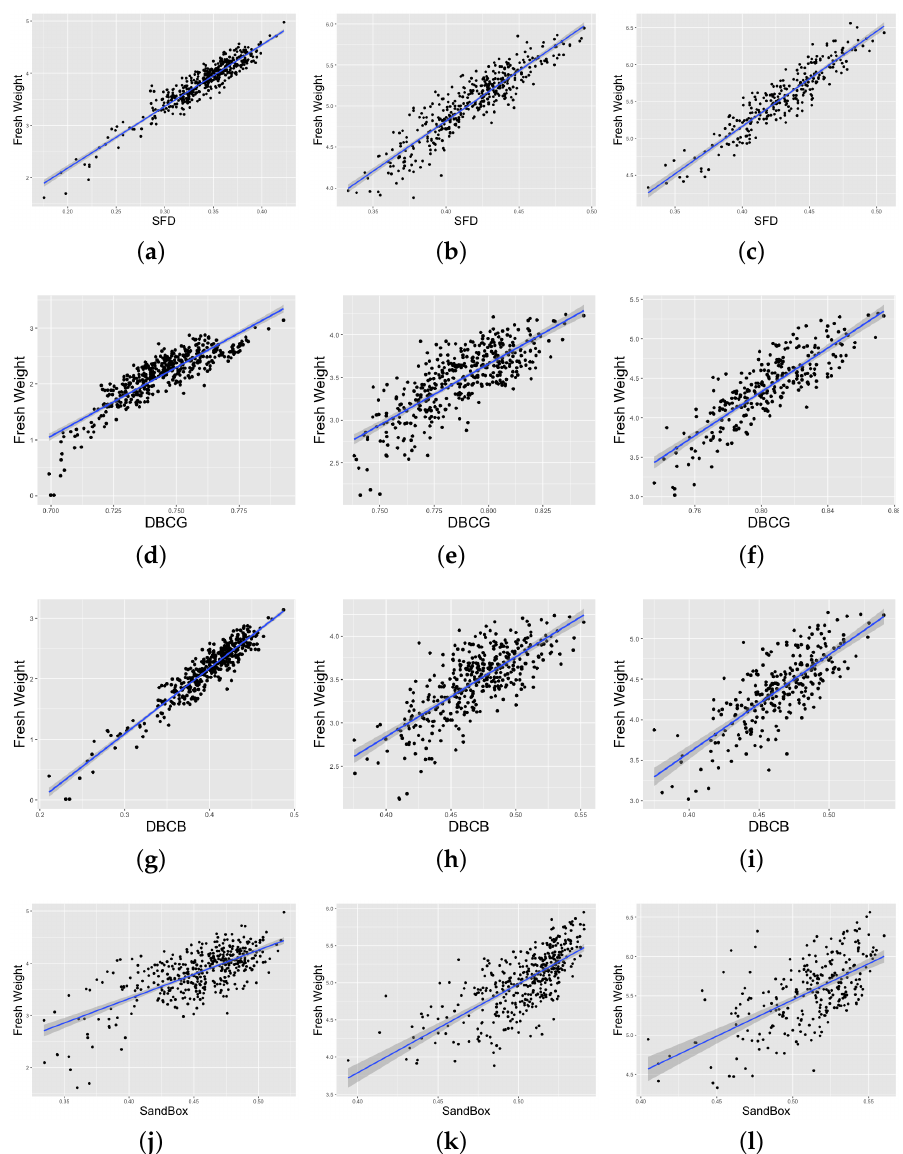
Figure A1. Fractal dimension fits the effect of plant fresh weight. ( a ) Late tillering stage. ( b ) Late booting stage. ( c ) Milk grain stage. ( d ) Late tillering stage. ( e ) Late booting stage. ( f ) Milk grain stage. ( g ) Late tillering stage. ( h ) Late booting stage. ( i ) Milk grain stage. ( j ) Late tillering stage. ( k ) Late booting stage. ( l ) Milk grain